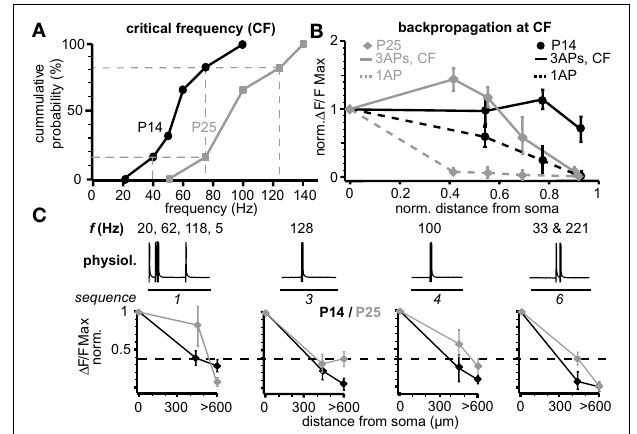
FIGURE 7 | Maturation of back-propagation during postnatal development. (A) Cumulative probability plot of the CFs for short trains of three APs for layer 5A pyramidal neurons at P14 and P25 ( n = 6 for each age group). Dashed lines indicate the CF-ranges from 40–75 Hz at P14 and 75–125 Hz at P25 (corresponding to 1/6 and 5/6 of cumulative probability). (B) Normalized (to soma) peak Δ F/F Ca 2 + signals evoked by single APs and bursts of three APs at the respective CF at P14 (60–75 Hz) and P25 (100–125 Hz) as function of normalized distance from soma (mean ± sem, n = 6 for each age group). (C) Normalized peak Δ F/F Ca 2 + signals of physiological fi ring patterns (sequences 1, 3, 4, and 6) as function of distance from soma for P14 and P25 L5A pyramidal neurons (mean ± sem, n = 9 for each age